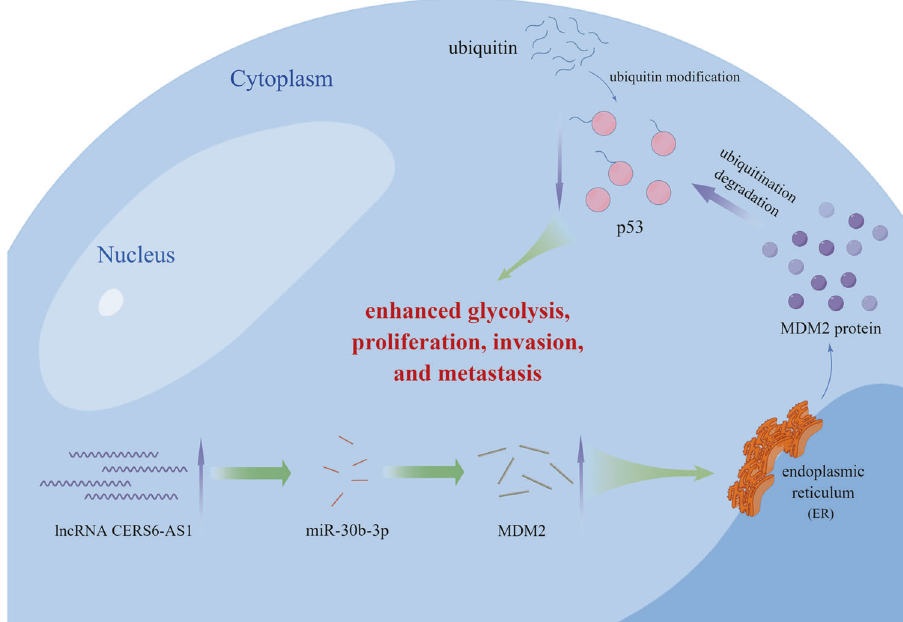
Fig. 9 The mechanism diagram of CERS6-AS1 promoting HCC progression. CERS6-AS1 sponges miR-30b-3p and upregulates MDM2, leading to increase of p53 degradation by ubiquitination. Eventually, CERS6-AS1 promotes cell proliferation, migration and invasion and induces cellular metabolic remodeling. (The diagram is drawn by Figdraw (www. fi gdraw.com)).